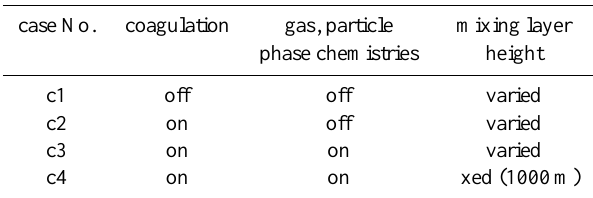
Table 3. Schemes used in different cases of the PartMC-MOZAIC